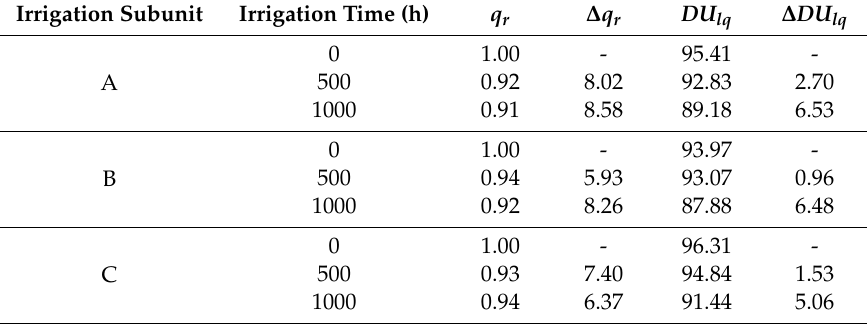
Table 3. Relative flow ( q r ) and relative flow variation ( ∆ q r ), distribution uniformity coefficient ( DU lq ) and distribution uniformity coefficient variation ( ∆ DU lq ) at the beginning, after 500, and 1000 h of each irrigation subunit.